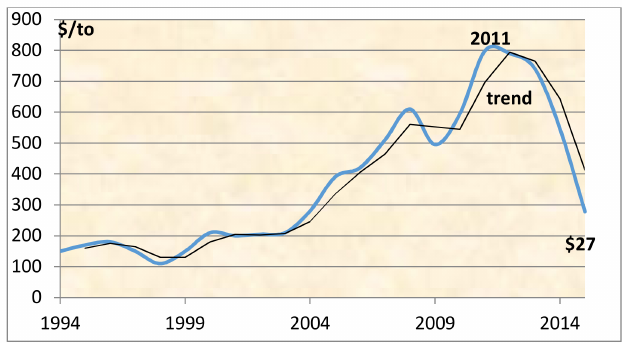
Figure 12. Oil prices, $ per ton, 1994–2015. Source: Author and excel, numbers from Furuichi and Otsuka (2015) and UNCTAD for